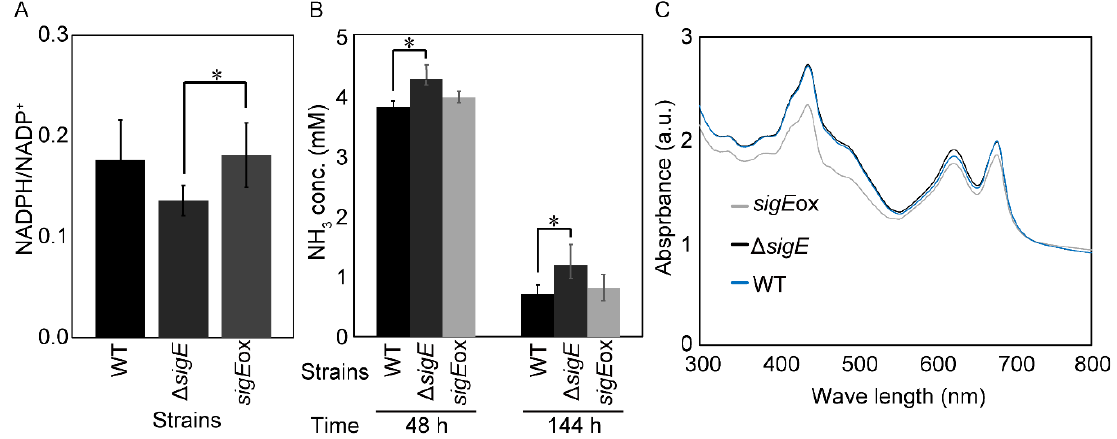
Figure 6. Effect of sigE deletion and overexpression on phenotypes of Synechocystis sp. PCC 6803. ( A ) NADPH/NADP + ratio. ( B ) NH 3 concentration in the medium. Values are means ± SD of three independent experiments. Differences were assessed with two-sided Student’s t -tests with an alpha level of 0.05. Asterisks indicate a significant difference ( p < 0.05). ( C ) UV-VIS spectra. Absorbance levels were normalized as ABS730 as